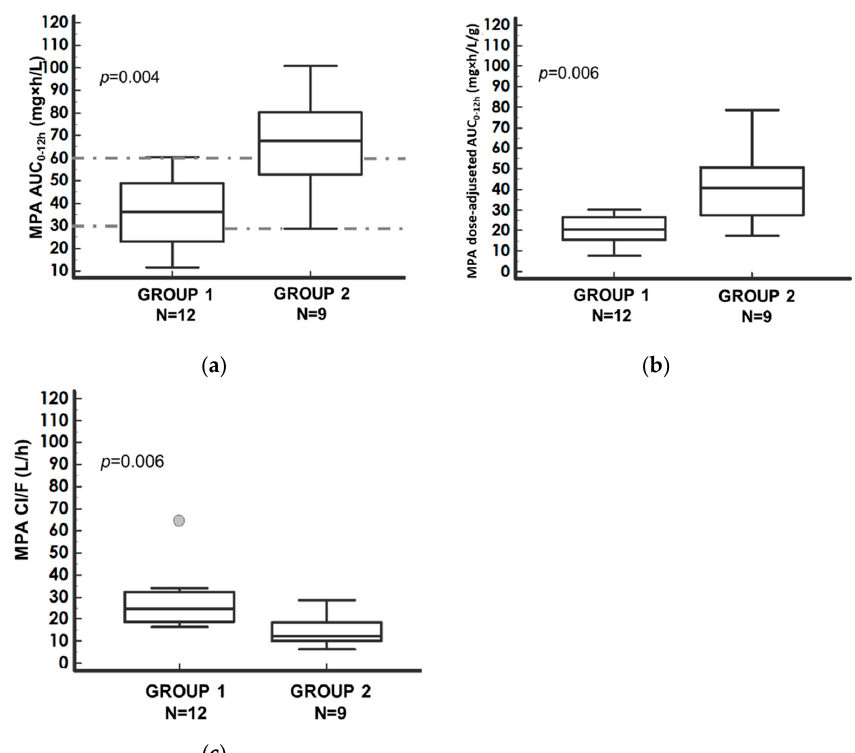
Figure 1. Comparison of ( a ) MPA–AUC 0–12h ; ( b ) dose-adjusted MPA–AUC 0–12h ; ( c ) MPA–CL/F, between Group 1 (MMF + CsA group) and Group 2 (MMF + TAC group) and corresponding p -value of the Mann–Whitney test. Median values with the corresponding 95% confidence intervals (bars). Dots represent the outliers. In ( a ), the interval between the dotted lines represents the therapeutic range (30–60 mg · h/L). Nomenclature: AUC 0–12h —area under the 12 h concentration–time curve;